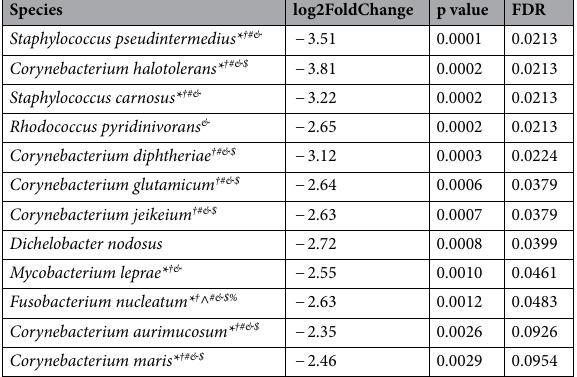
Table 3. The 12 significant species between the CAD and healthy groups (FDR < 10%). *Contaminant; # Hard palate; & Soft palate; % Tonsils; $ Tooth surfaces; † Subgingival and supragingival plaques; § Subgingival.